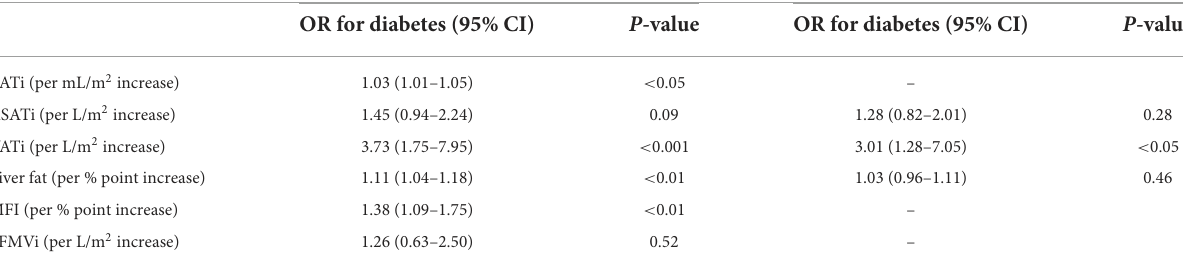
TABLE 5 Logistic regression analyses. Univariate models Multivariate